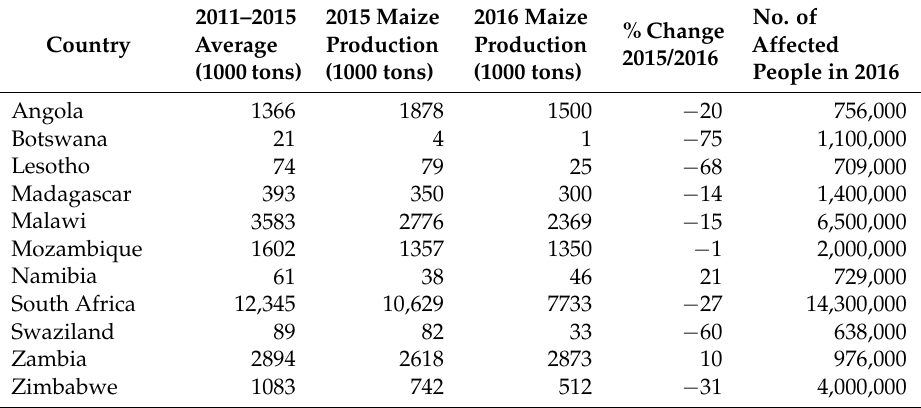
Table 1. 2016 maize production deficit in SADC countries and the number of affected people.